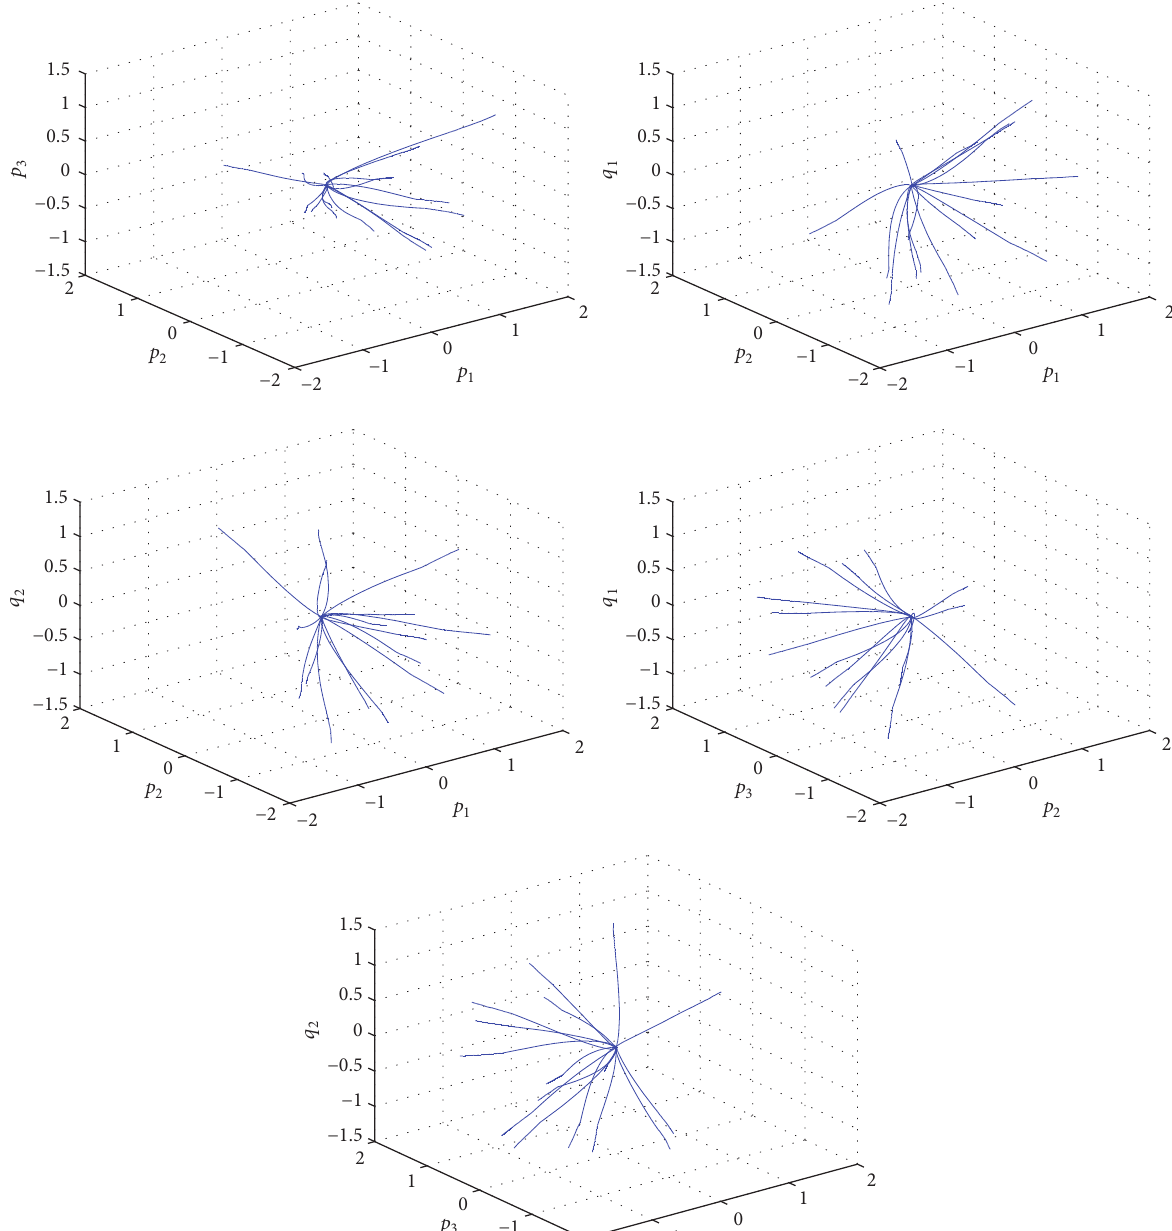
Figure 2: Phase portraits of system (39) in the three-dimensional